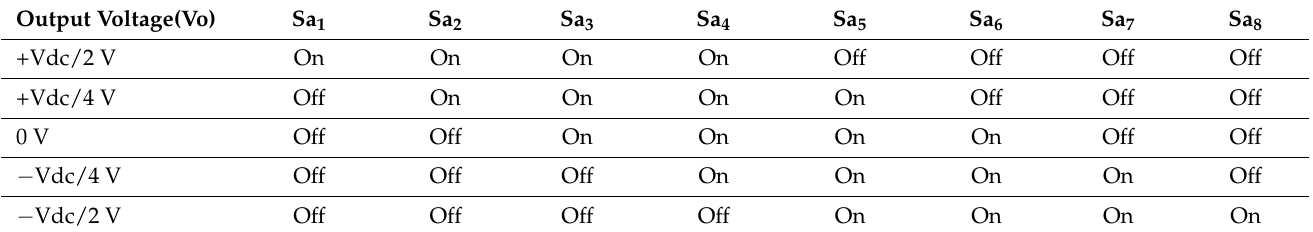
Table 3. Switching positions of NPC -MLI.